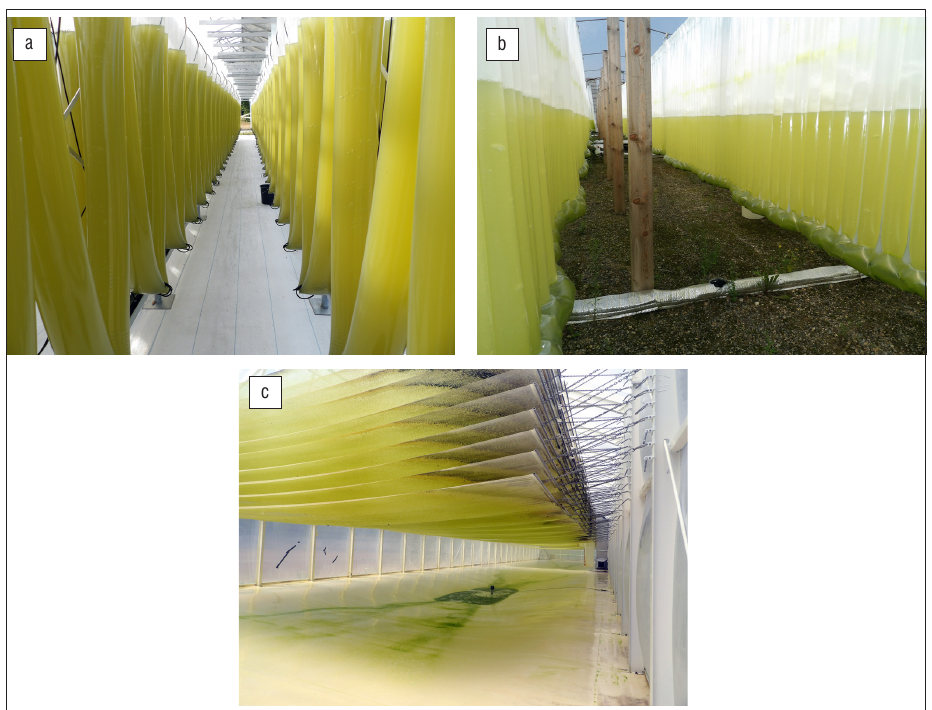
Figure 1: Three photobioreactors at the AUFWIND project. (a) Novagreen photobioreactor, housed in a glasshouse, comprising 1338 V-bags each containing 25 L culture (note the yellow colour, typical of lipid-rich microalgae); (b) the Phytolutions photobioreactor is made up of six sections, each containing up to 10 ‘curtains’ of vertical tubes interconnected with a horizontal tube at the bottom; and (c) stacked horizontal mesh sheets of the IGV system, housed in a plastic-covered